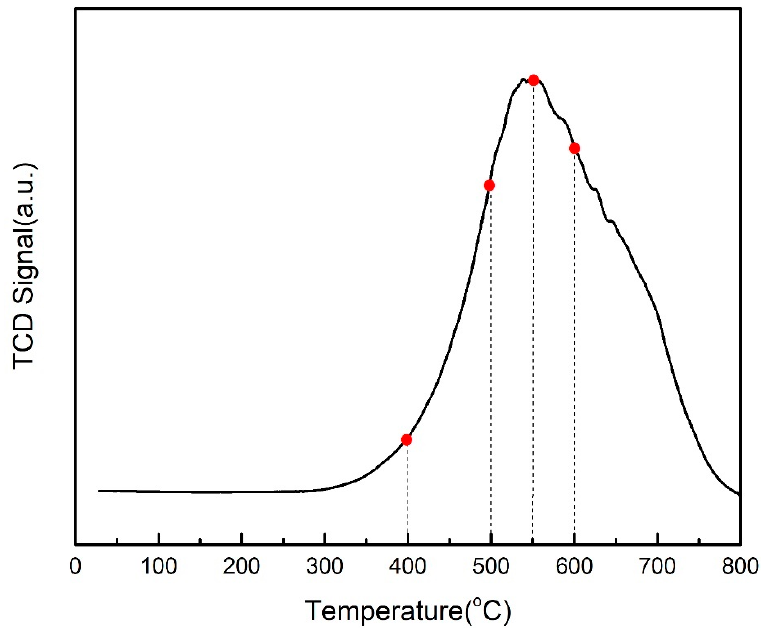
Figure 10. H 2 -TPR profile of AMO-Ni 3 Al 1 -CO 3 -LDO solid.